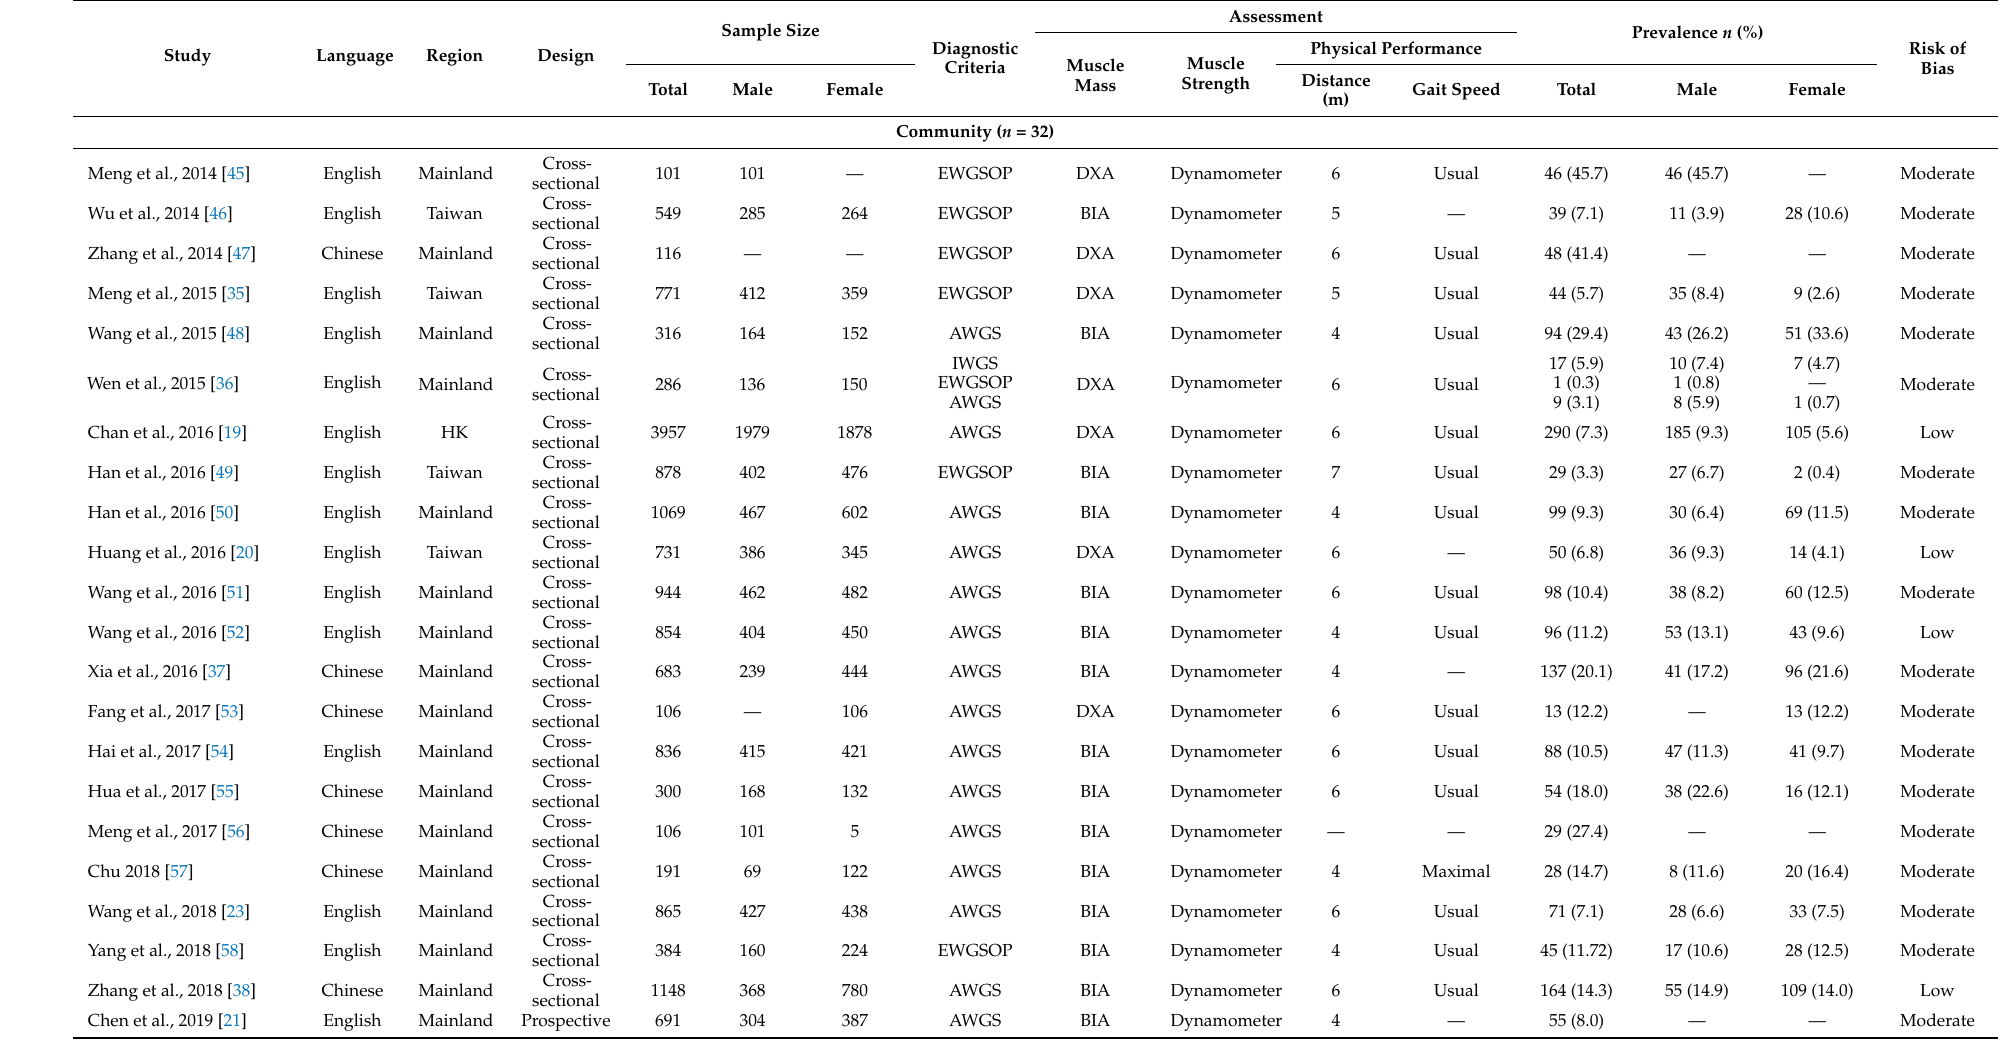
Table 1. Characteristics of included studies ( n =